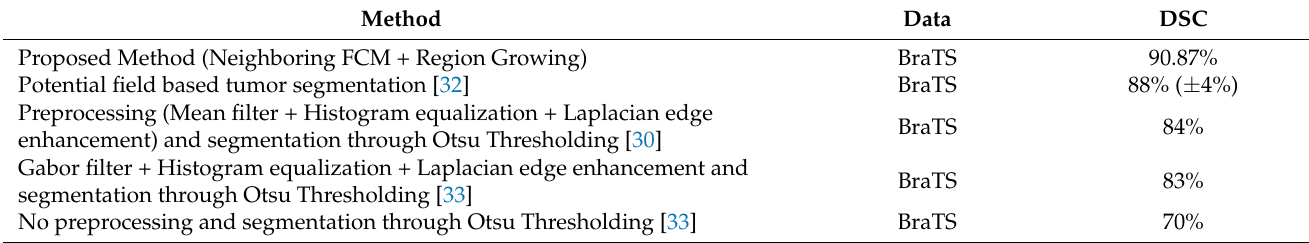
Table 11. Comparison of the proposed brain Tumor Segmentation method with latest literature techniques.